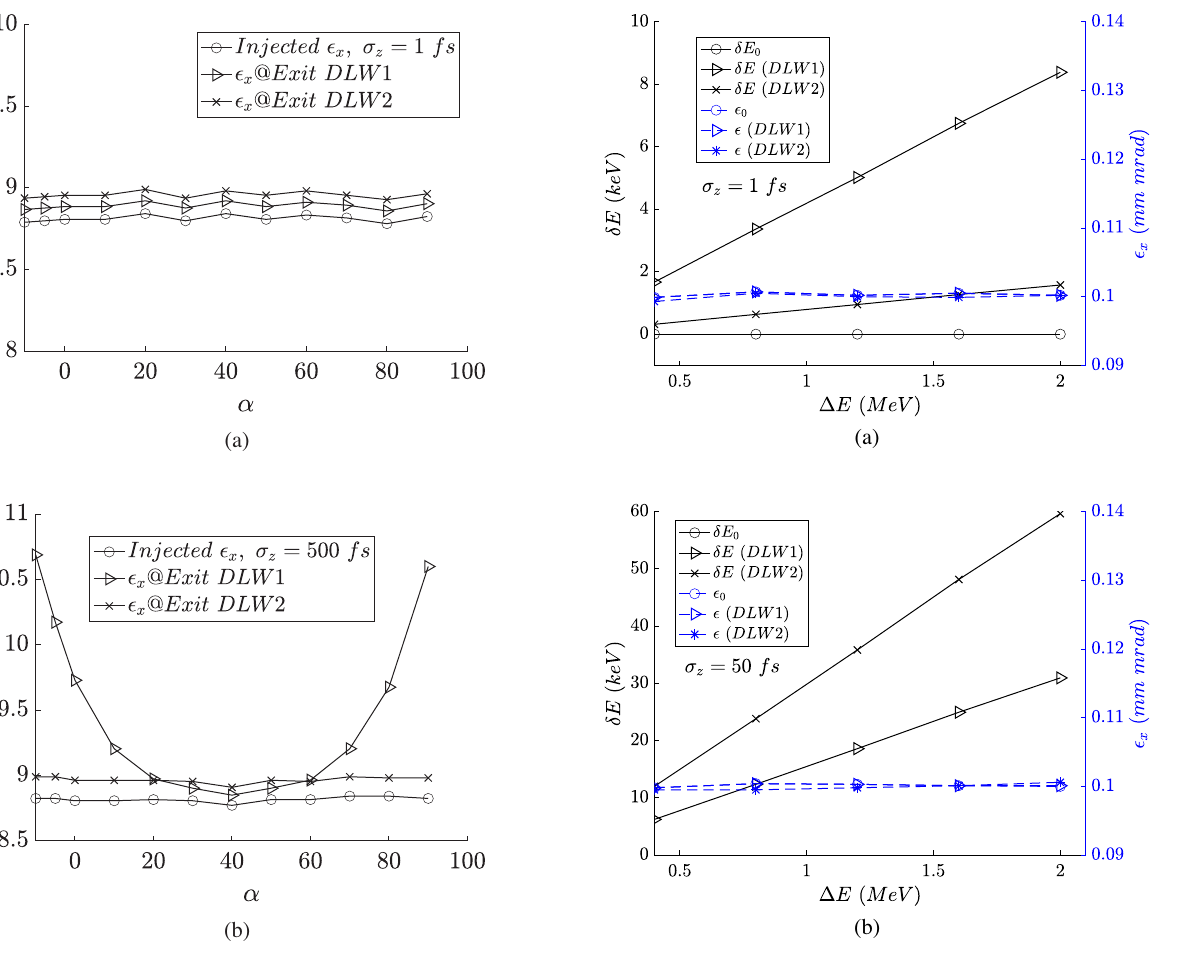
FIG. 14. Evolution of transverse beam emittance for (a) a slice (1 fs) and (b) a 50 fs long bunch as a function of focusing conditions imposed while the beam is incident at the first structure entrance.